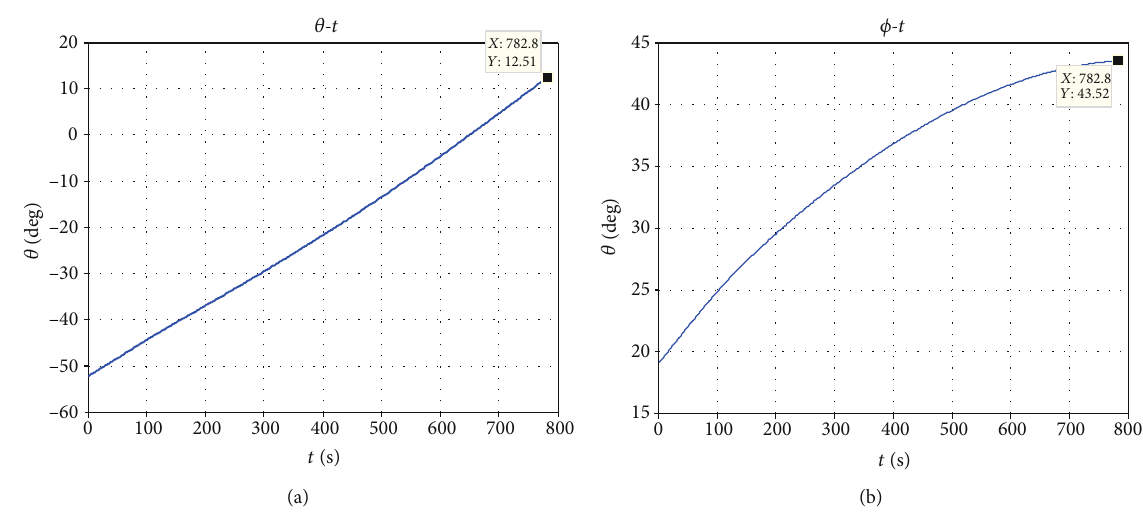
Figure 9: Time history of (a) geocentric longitude θ and (b) latitude φ